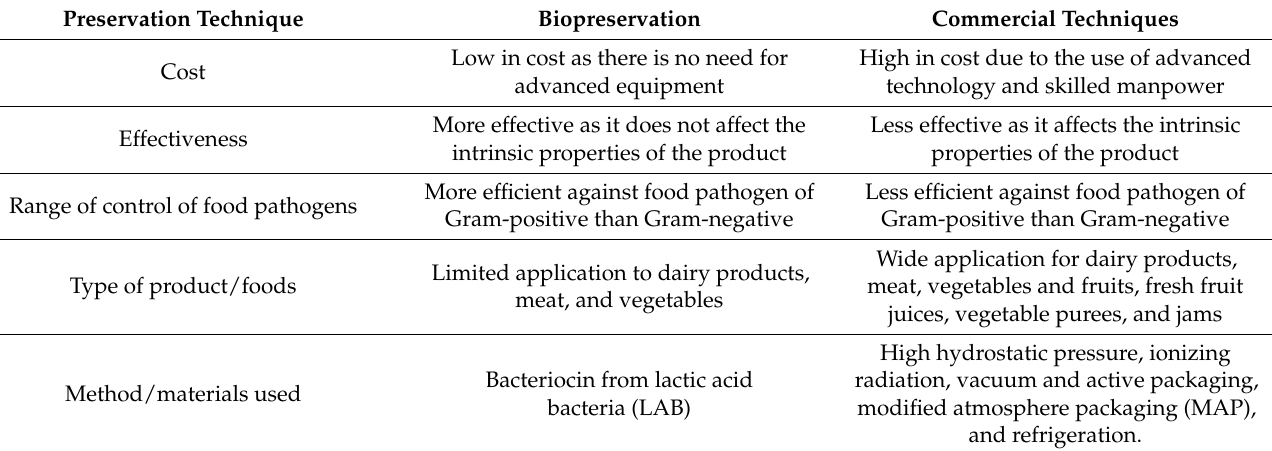
Table 6. Comparison of preservation method by biopreservation and commercial